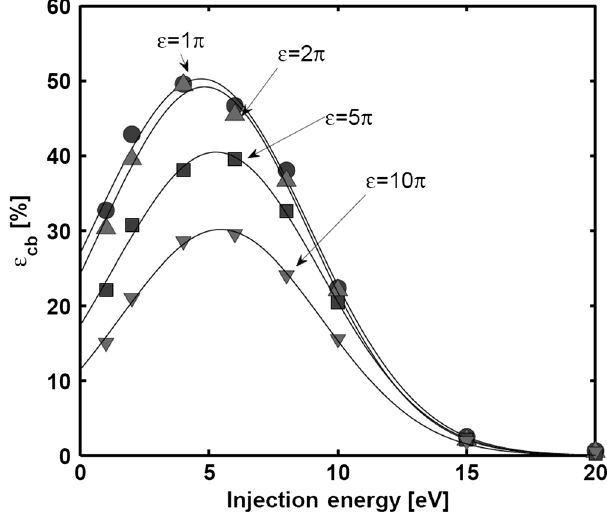
FIG. 2. 85 Rb 1 þ ions capture as a function of the injection energy inside the charge breeder for the reference simulations. The numerical results are very well fitted by a Gaussian curve.